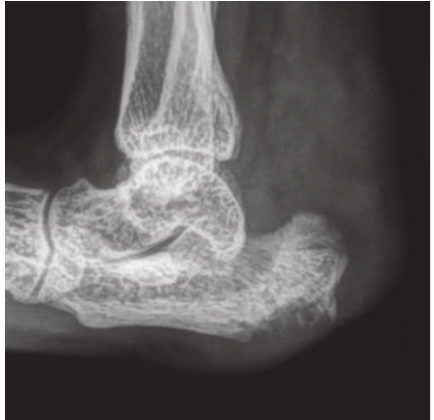
Figure 2: Radiographs of the animal’s foot taken 26 days before the surgical